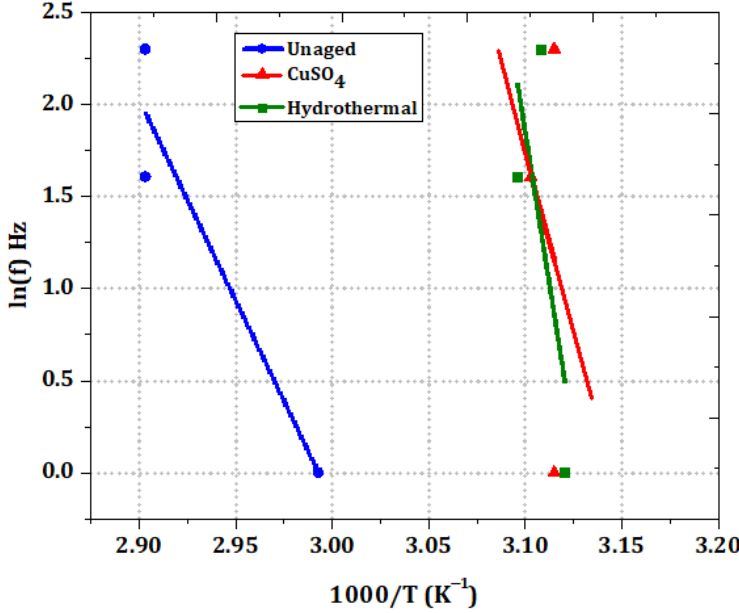
Figure 9. Activation energy plot for unaged and aged XLPE samples.